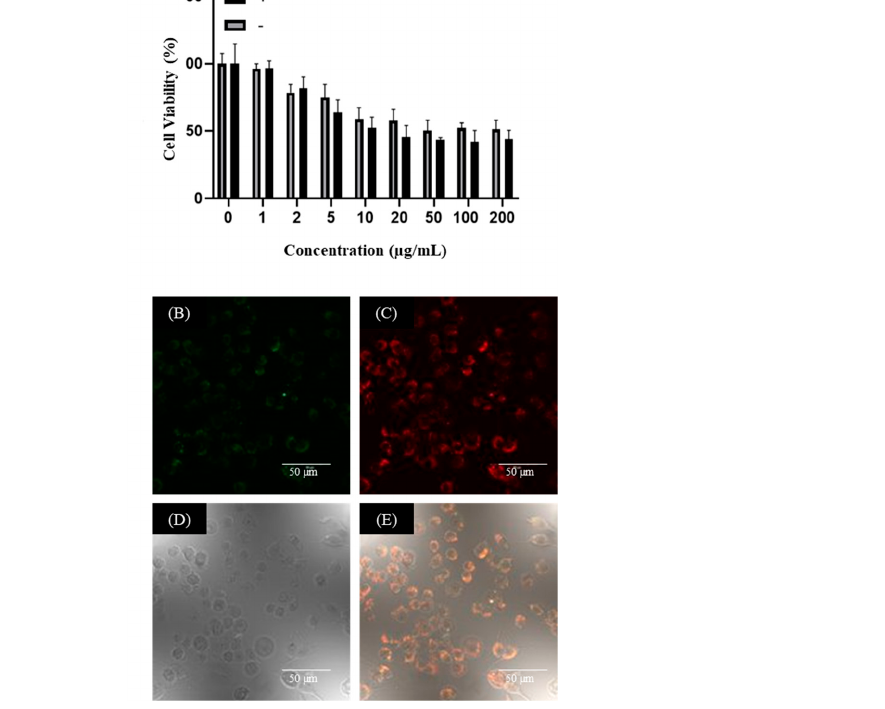
Figure 10. PDT treatment of RAW 264.7 cells with GQDs-hMSNs. ( A ) LDH assay cytotoxicity analysis after 24 h treatment at different concentrations (0–200 µg/mL); (+), 785 nm laser irradiation; ( − ), no laser irritation. Confocal microscope images of LysoTracker Red with 200 µg/mL GQDs-hMSNs ( B ) 488 nm laser, ( C ) 561 nm laser, ( D ) TD, ( E ) merged.